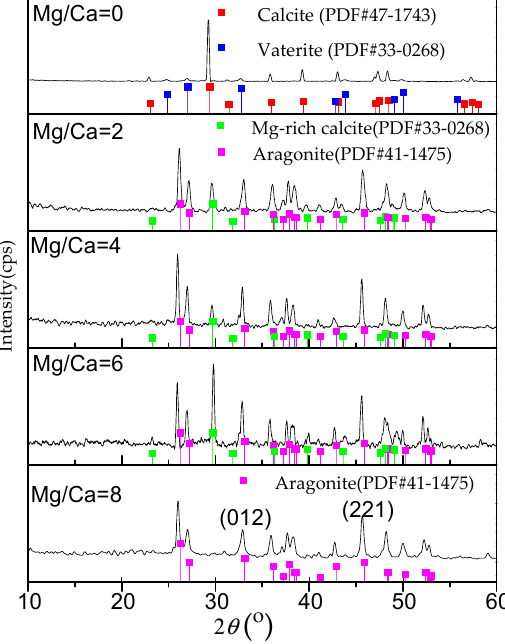
Figure 2. X-ray di ff raction analyses of the biotic minerals cultivated for 14 Figure 2. X-ray diffraction analyses of the biotic minerals cultivated for 14 days.